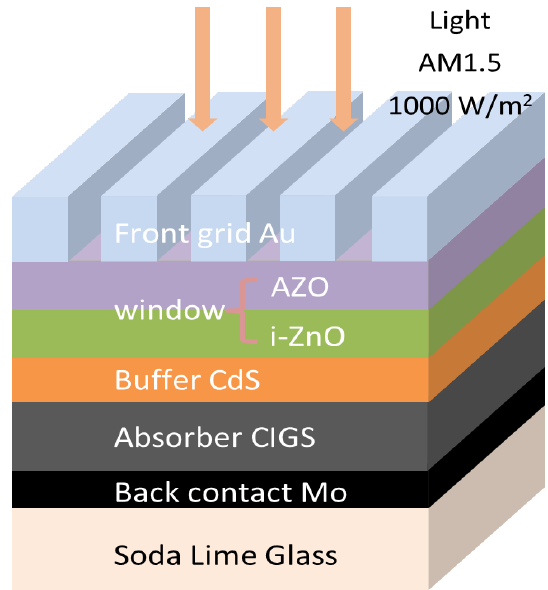
Figure 2. Device architecture of the simulated CIGS solar cell. The parameters for different layers in the simulated devices are listed in Table 1. The J - V curves, EQE curves, J sc , V oc , fill factor (FF), and PCEs for the simulated devices were obtained under the condition of AM1.5 G, an incident solar power ( P ) of 100 mW/cm 2 , and a temperature of 300 K. In addition, the band diagram and C - V curves were also obtained. Table 1. Input simulation parameters for different layers in CIGS and BTO-coupled CIGS solar cells [31 – 33].